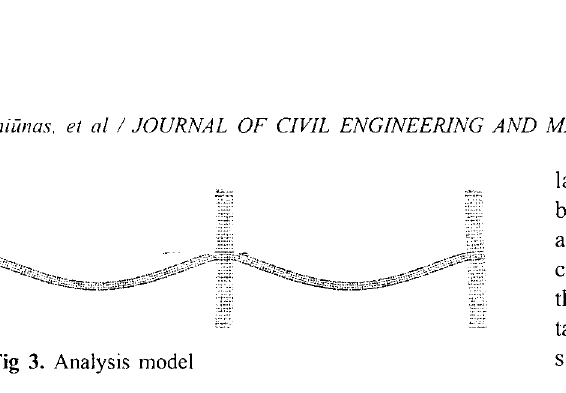
Stress Point Bounding Surface of Higrer Damage